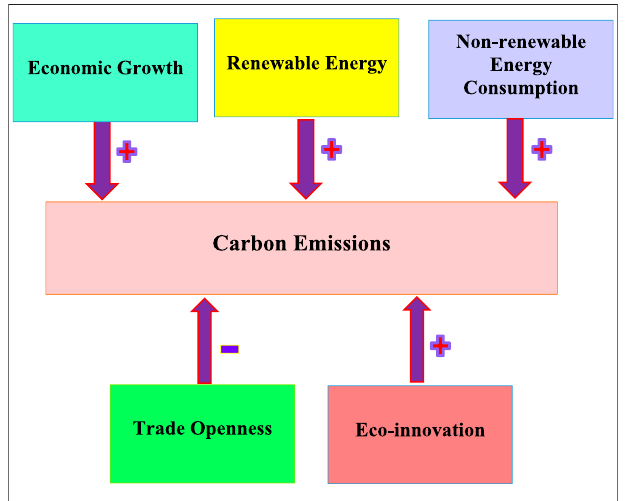
FIGURE 2 | Empirical fi ndings from FMOLS, DOLS and panel quantile